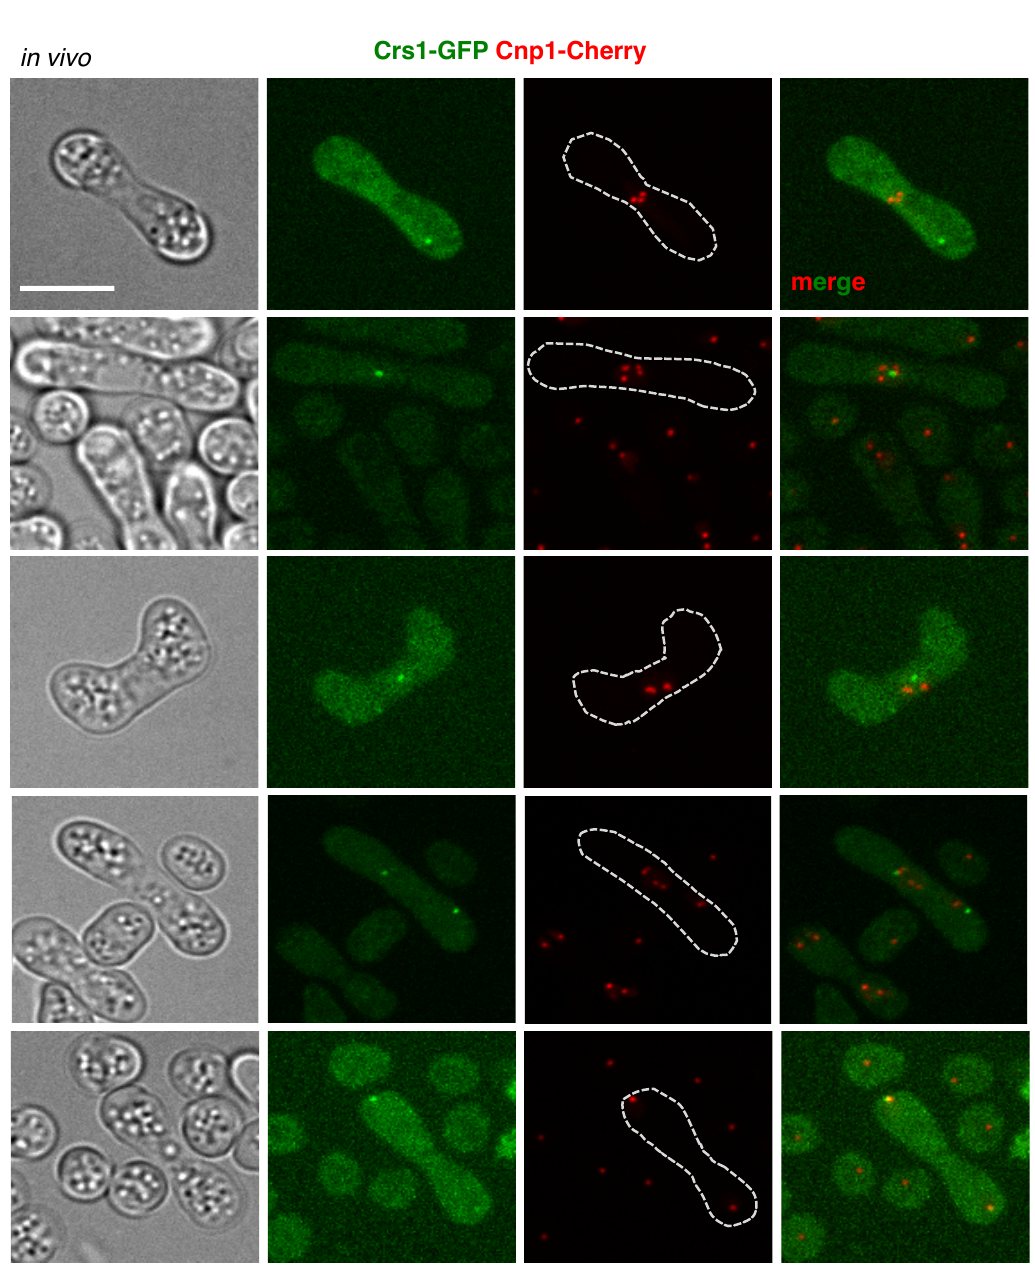
Figure 6. In vivo Crs1-GFP and Cnp1-Cherry localization. Top panels: Schematic drawing of SPB, centromeres, and telomeres position during prophase and meiosis I is shown. Bottom panels: In vivo Crs1-GFP and Cnp1-Cherry (centromere component) distribution in prophase and meiosis I in h 90 zygotes (CMC1073). Single plane bright-field images on the left help to localize the nucleus, which appears as a smooth area more or less stretched depending on the nuclear movement in a rugged context. Notice Crs1-GFP pan-nuclear diffuse signal in the upper zygote. Crs1-GFP focus and pan-nuclear signal were not always visible in the same focal plane. Notice co-localization of Crs1-GFP and Cnp1-Cherry only at the cell poles in anaphase I (when centromeres of the segregating chromosomes reach the SPB). Crs1-GFP images correspond to single planes, and Cnp1-Cherry images correspond to maximal projections of Z sections. Scale bar corresponds to 5 µ